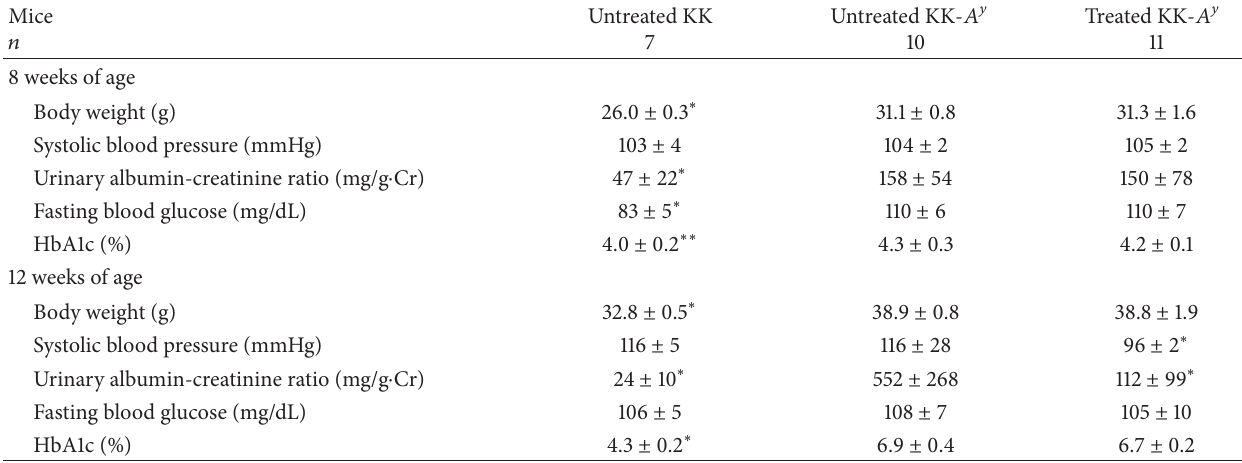
Table 1: Biochemical profiles of KK mice and KK- 𝐴 𝑦